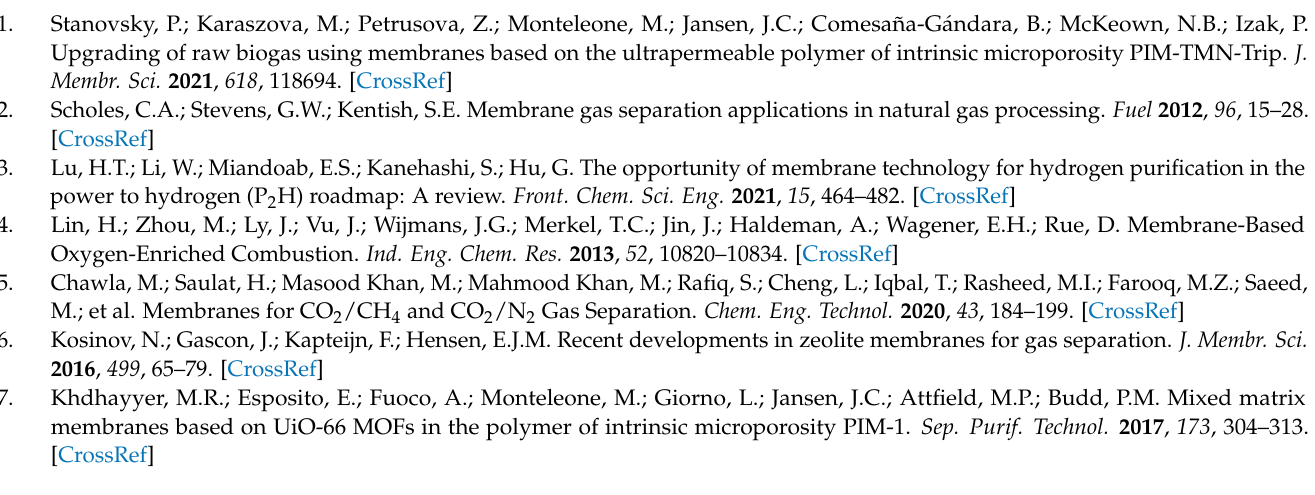
CDCl 3, , Figure S2: 1 H-NMR spectrum of m -xy in CDCl 3 , Figure S3: 1 H-NMR spectrum of p -xy in CDCl 3 , Figure S4: 1 H-NMR spectrum of the diphenyl cage in CDCl3, Figure S5: FTIR-ATR spectrum of Fura, Figure S6: FTIR-ATR spectrum of m -xy, Figure S7: FTIR-ATR spectrum of p -xy, Figure S8: FTIR-ATR spectrum of the diphenyl cage, Figure S9: DSC curve of Fura, Figure S10: DSC curve of m -xy, Figure S11: DSC curve of p -xy, Figure S12: DSC curve of the diphenyl cage, Figure S13: XRPD patterns of the p -xy (left) and diphenyl (right) cages